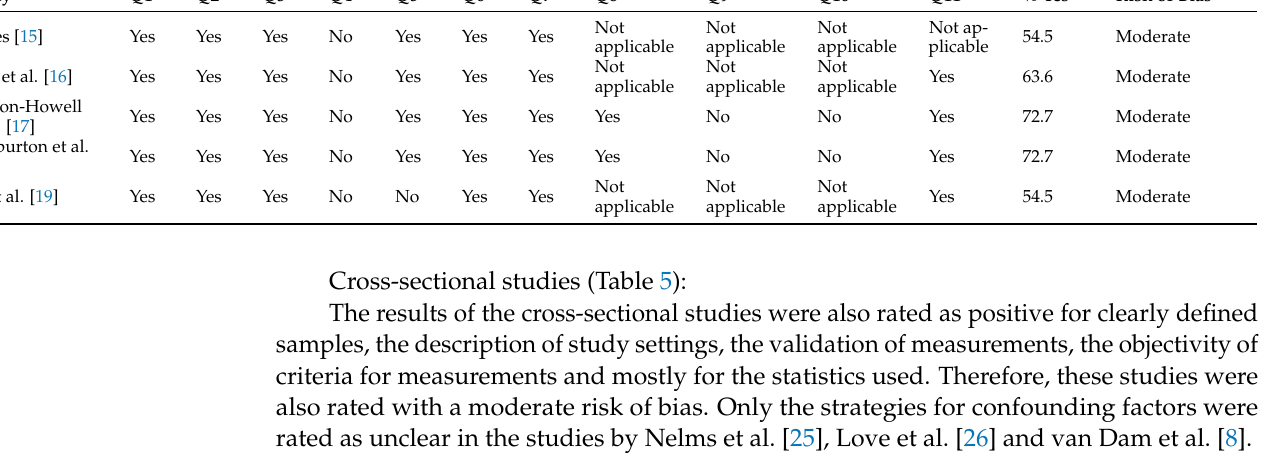
Table 5. Risk of bias assessment for cross-sectional studies according to the JBI tool (sorted in order of year of publication) [33].